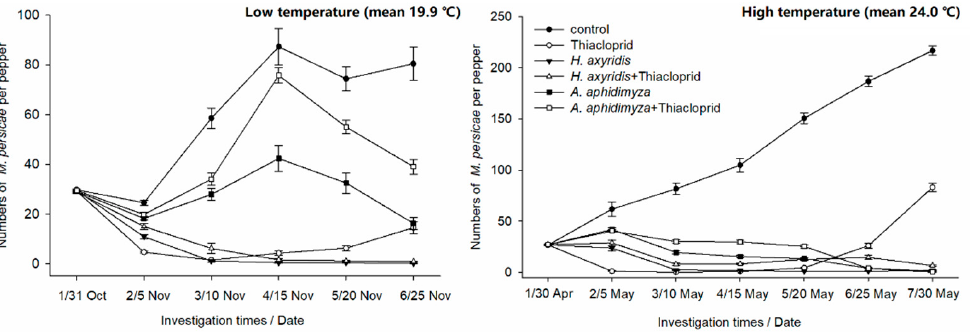
Figure 1. Population size of M. persicae on pepper seedlings with different predators and insecticide treatments within a greenhouse. Mean number of M. persicae ( ± SE) in low and high temperature. Highest numbers of H. axyridis or A. aphidimyza in each treatment were